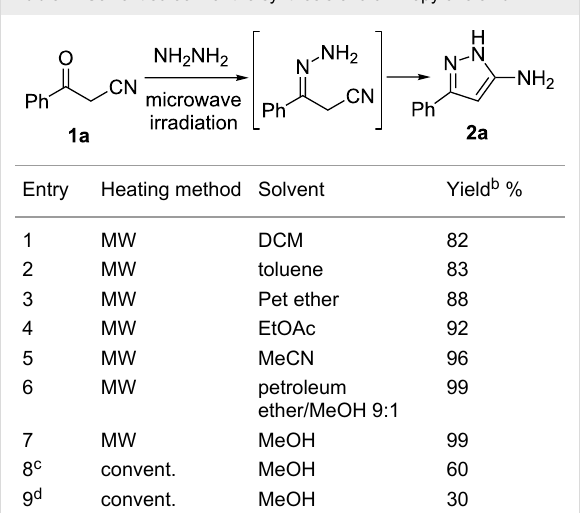
Table 1: Solvent screen for the synthesis of 5-aminopyrazole 2a .